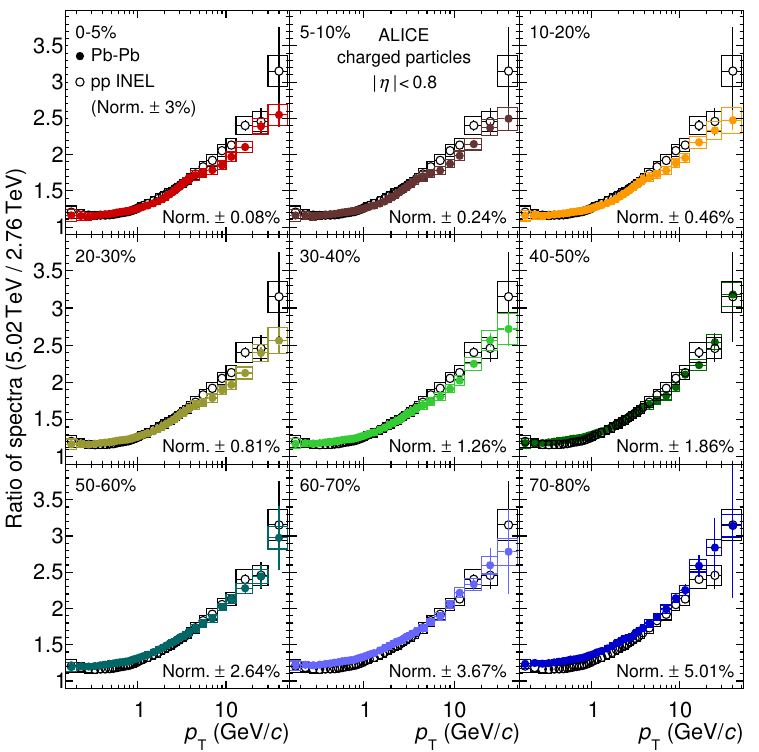
p p s NN = 5.02 and s NN = 2.76 TeV for Pb-